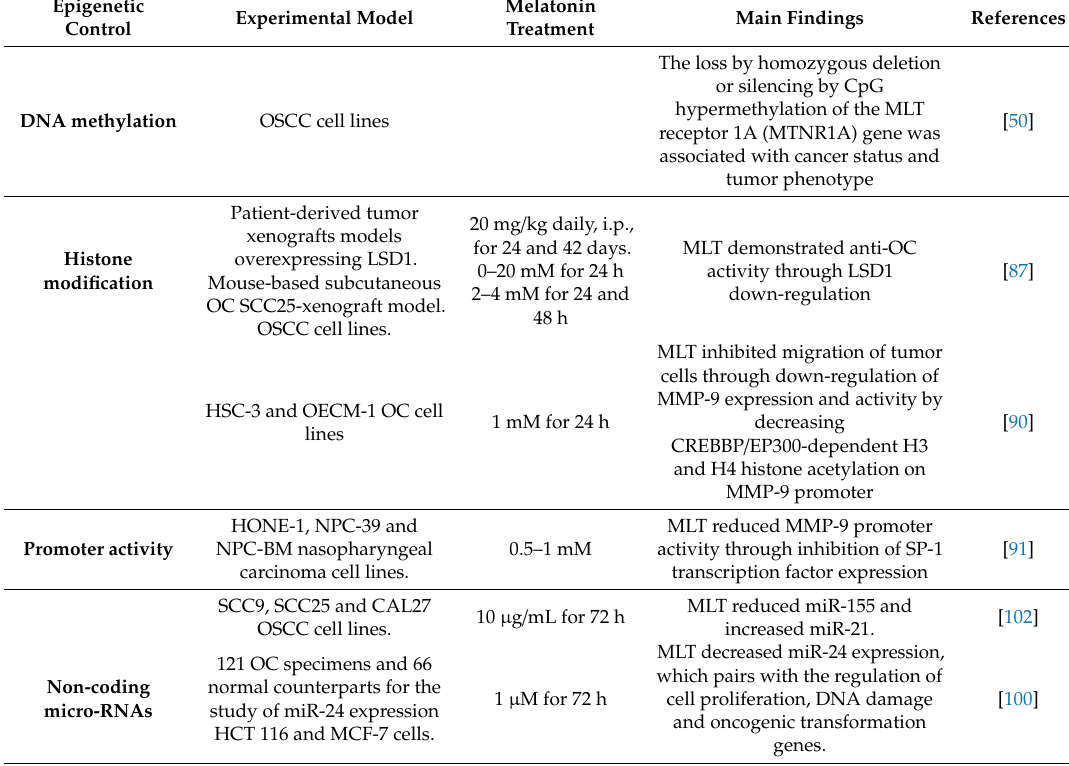
Table 3. Studies supporting the use of melatonin on epigenetic modulation of